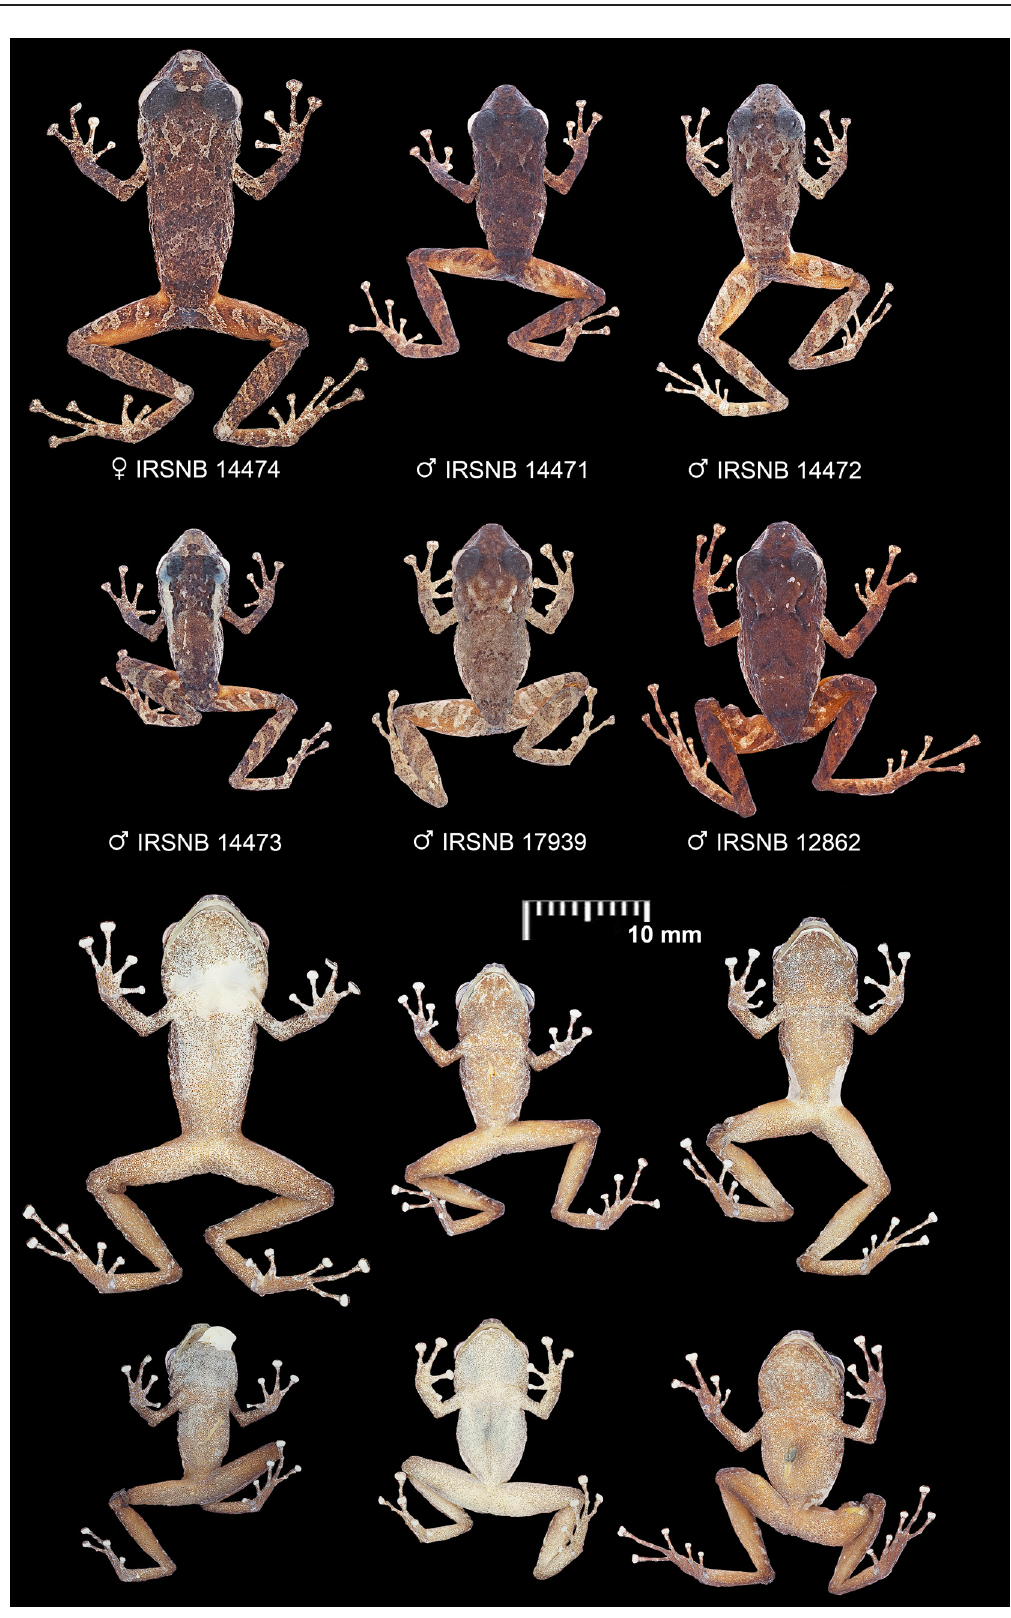
Fig. 5. Pristimantis marmoratus (Boulenger, 1900). Intraspecific variation in dorsal (top) and ventral (below) colour patterns in preserved specimens. Photographs